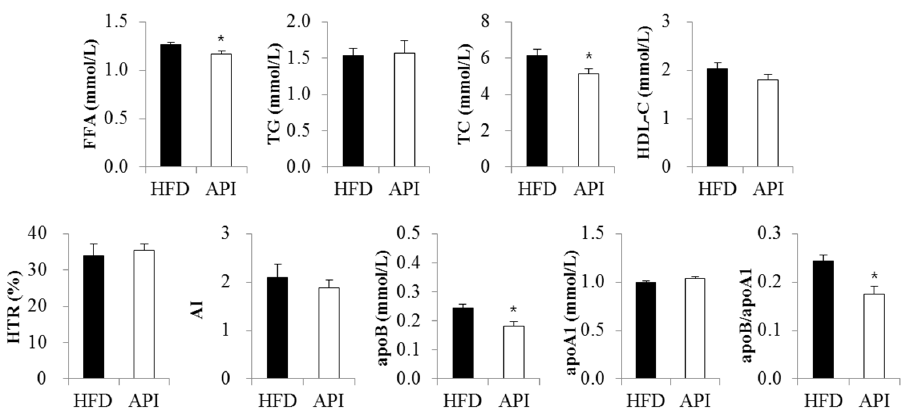
Figure 3. Effect of apigenin on plasma lipids and apolipoproteins in C57BL/6J mice fed a high ‐ fat diet. Data are shown as the means ± S.E. Values are significantly different between the high ‐ fat diet and apigenin groups according to Student’s t ‐ test: * p < 0.05. HFD: high ‐ fat diet (20% fat, 1% cholesterol); API: HFD + 0.005% apigenin.